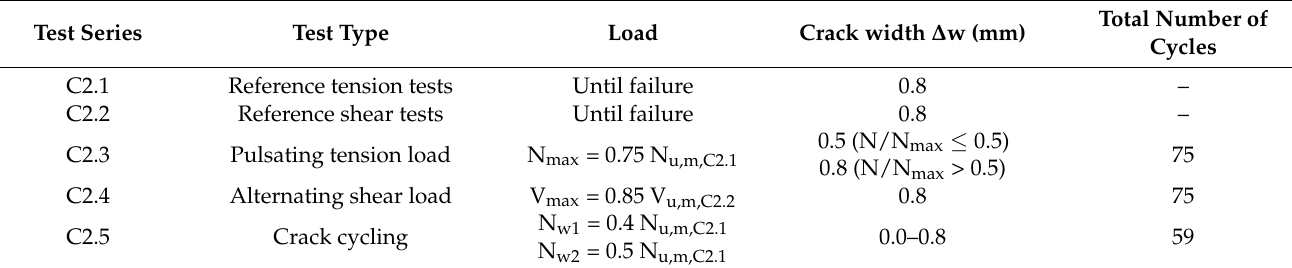
Table 1. Summary of required tests for category C2.